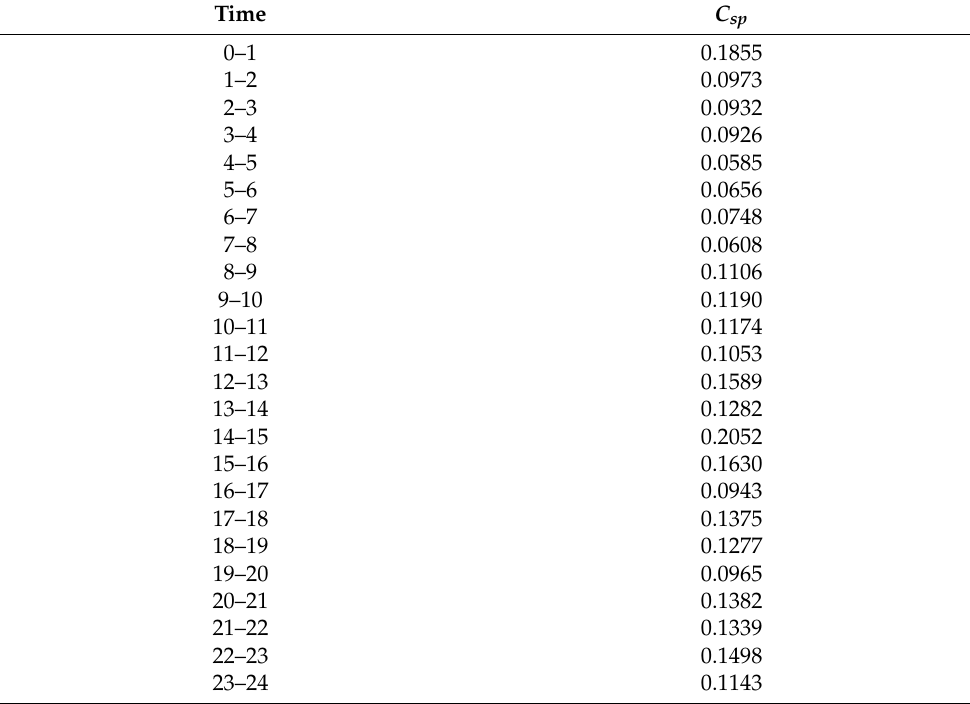
Table 3. The complexity on ship position for the studied PA.